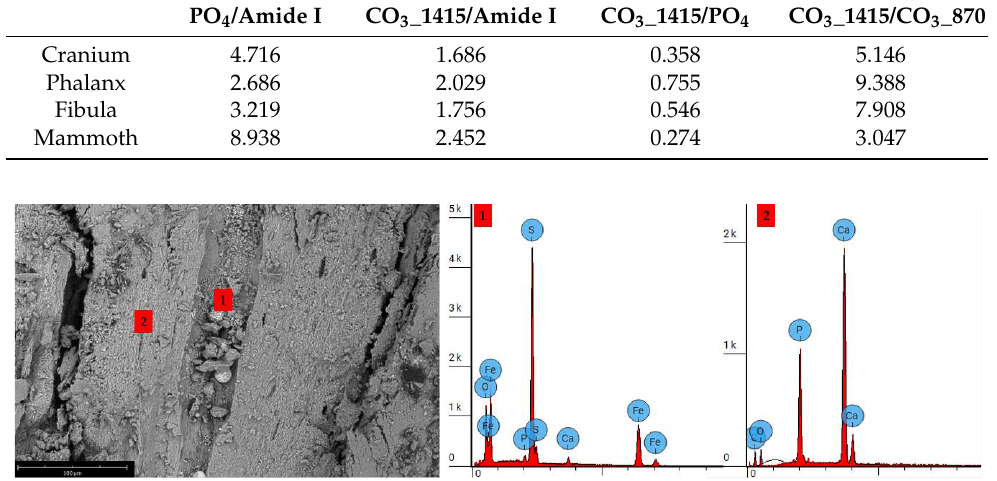
Figure 5. SEM images of mammoth bone samples showing the presence of a vascular canal filled by framboidal pyrites: (1) EDS bone (CaP), (2) pyrite (FeS 2 ) analyses.